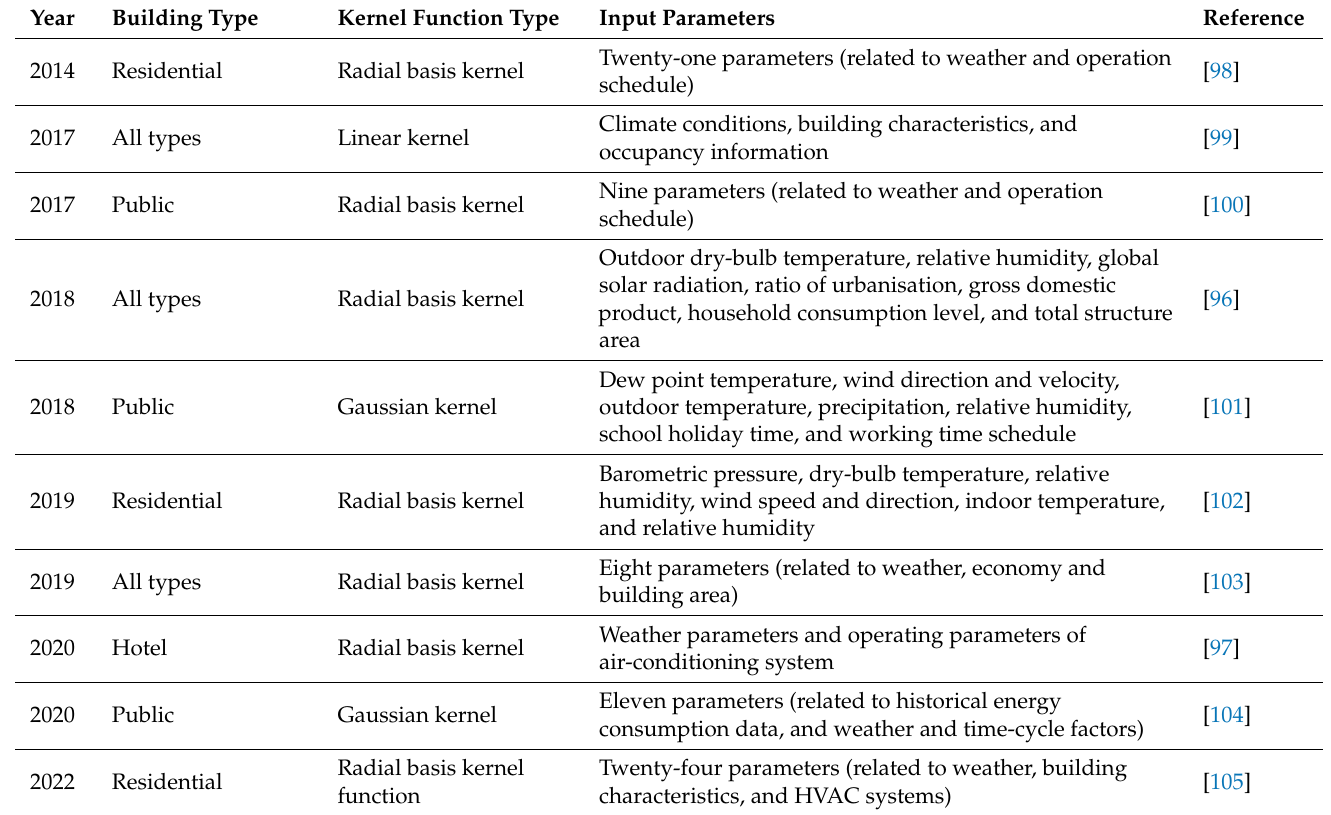
Table 3. Studies related to SVM